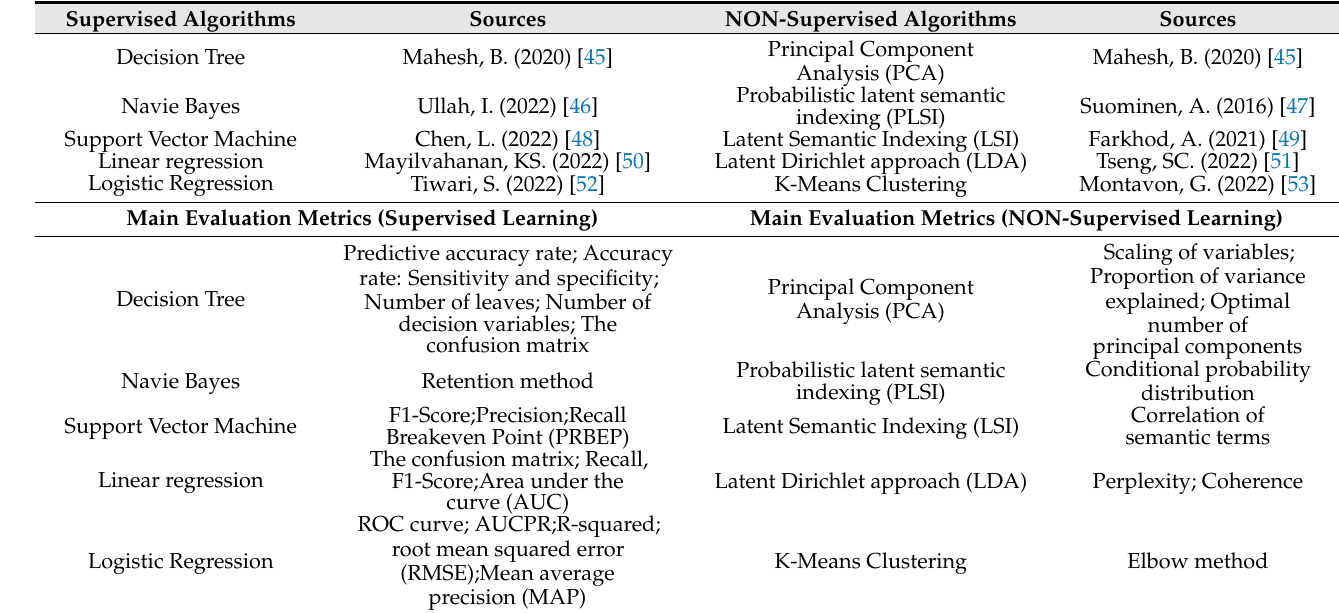
Table 2. Approaches supervised and unsupervised algorithms with main metrics; own